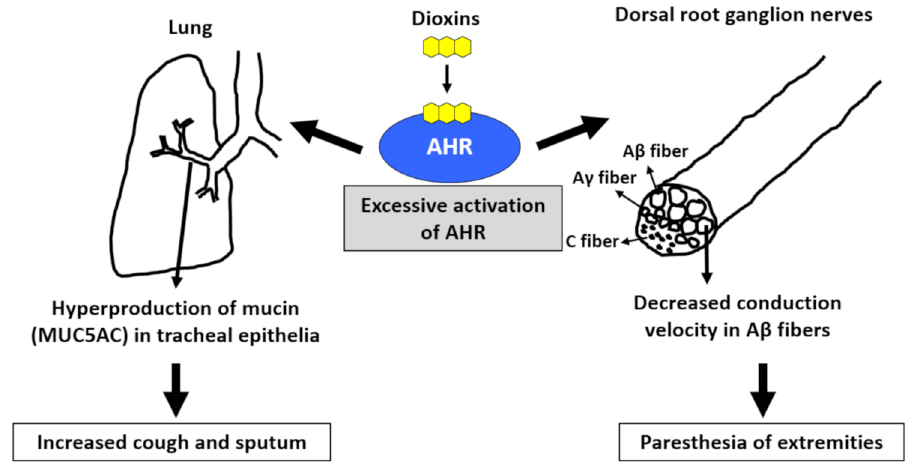
Figure 3. Excessive activation of aryl hydrocarbon receptor (AHR) by dioxins induces cough and sputum as well as paresthesia of the extremities. Activation of AHR increases the production of mucin (MUC5AC) in tracheal epithelial cells, which may cause increased cough and sputum. Activation of AHR ameliorates the conduction velocity of A β fibers in the dorsal root ganglion nerves. This may cause paresthesia of the